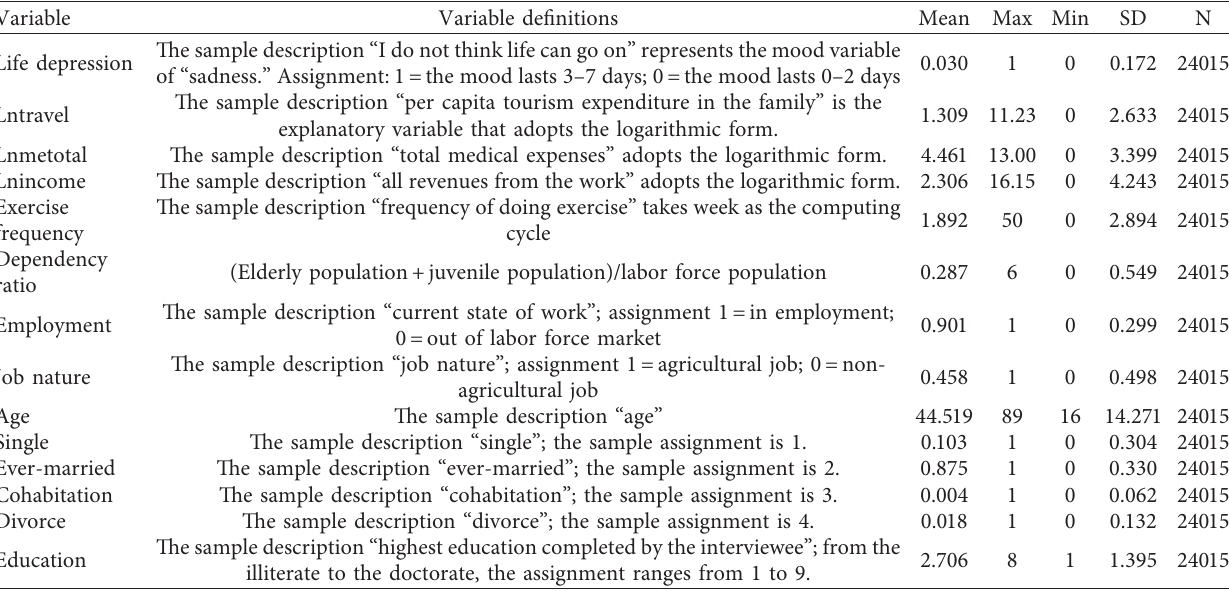
Table 1: Descriptive statistics of variables.